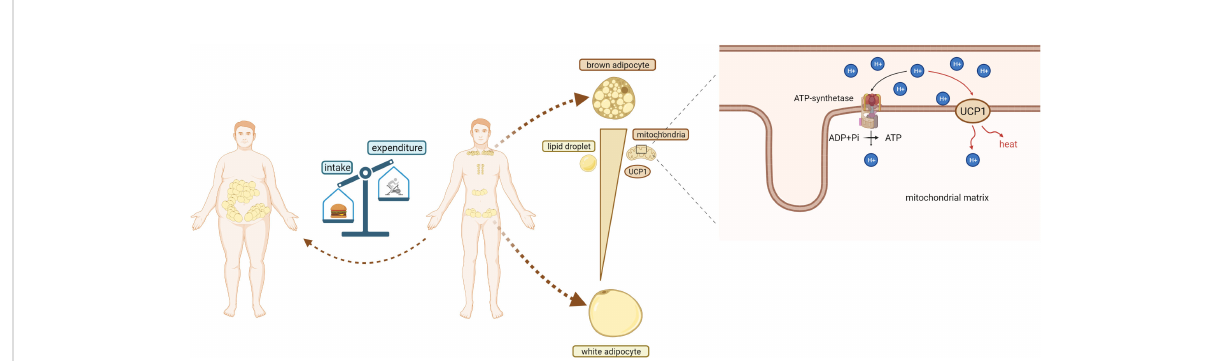
FIGURE 1 Obesity and BAT.Obesity occurs when the body ’ s energy intake is greater than its energy consumption. In adults, BAT is found in the back scapula and clavicle area, around the heart and kidneys, and WAT is located around the viscera and groin. Compared with white adipocytes, brown adipocytes contain a large number of mitochondria and high expression of UCP1. Brown adipocytes also has a small volume and a large number of lipid droplets. In mitochondria of brown adipocytes, UCP1 mediates protons to pass through the inner membrane of mitochondria, dissipating proton (H+) gradient and generating